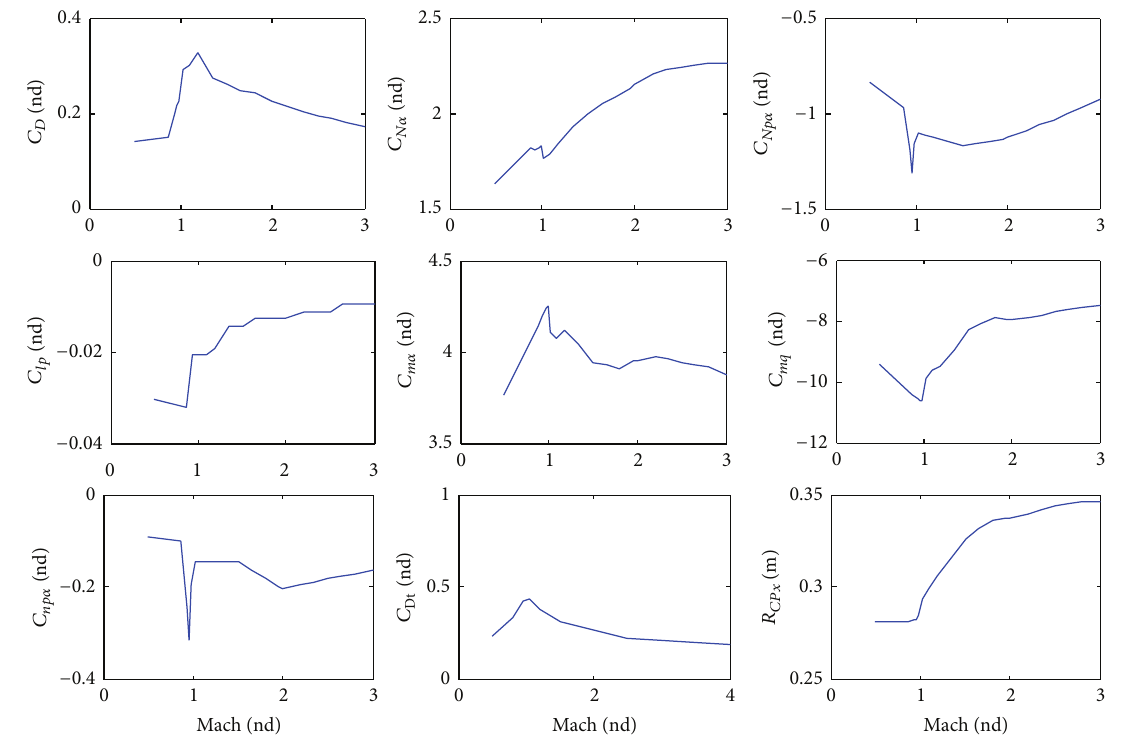
Figure 5: Body aerodynamic parameters versus Mach number.